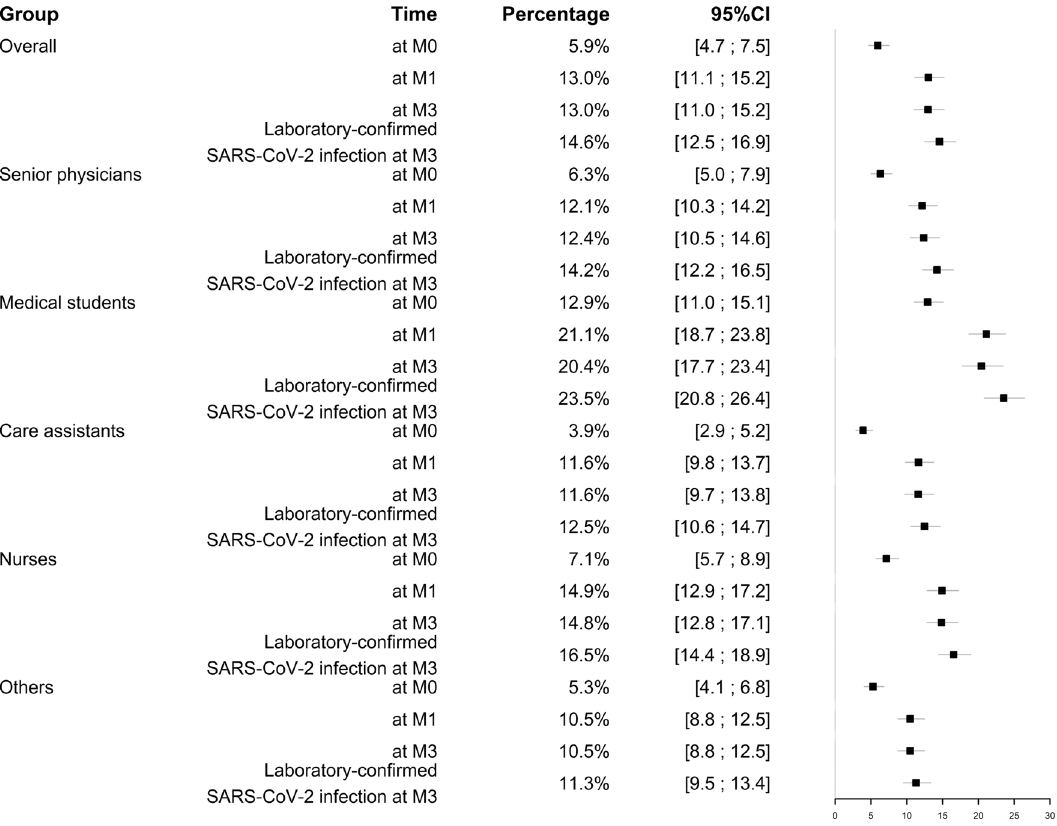
Figure 3. Laboratory-confirmed infection with SARS-CoV-2 at month 3 (M3) and seroprevalence at M0, M1 and M3 according to professional